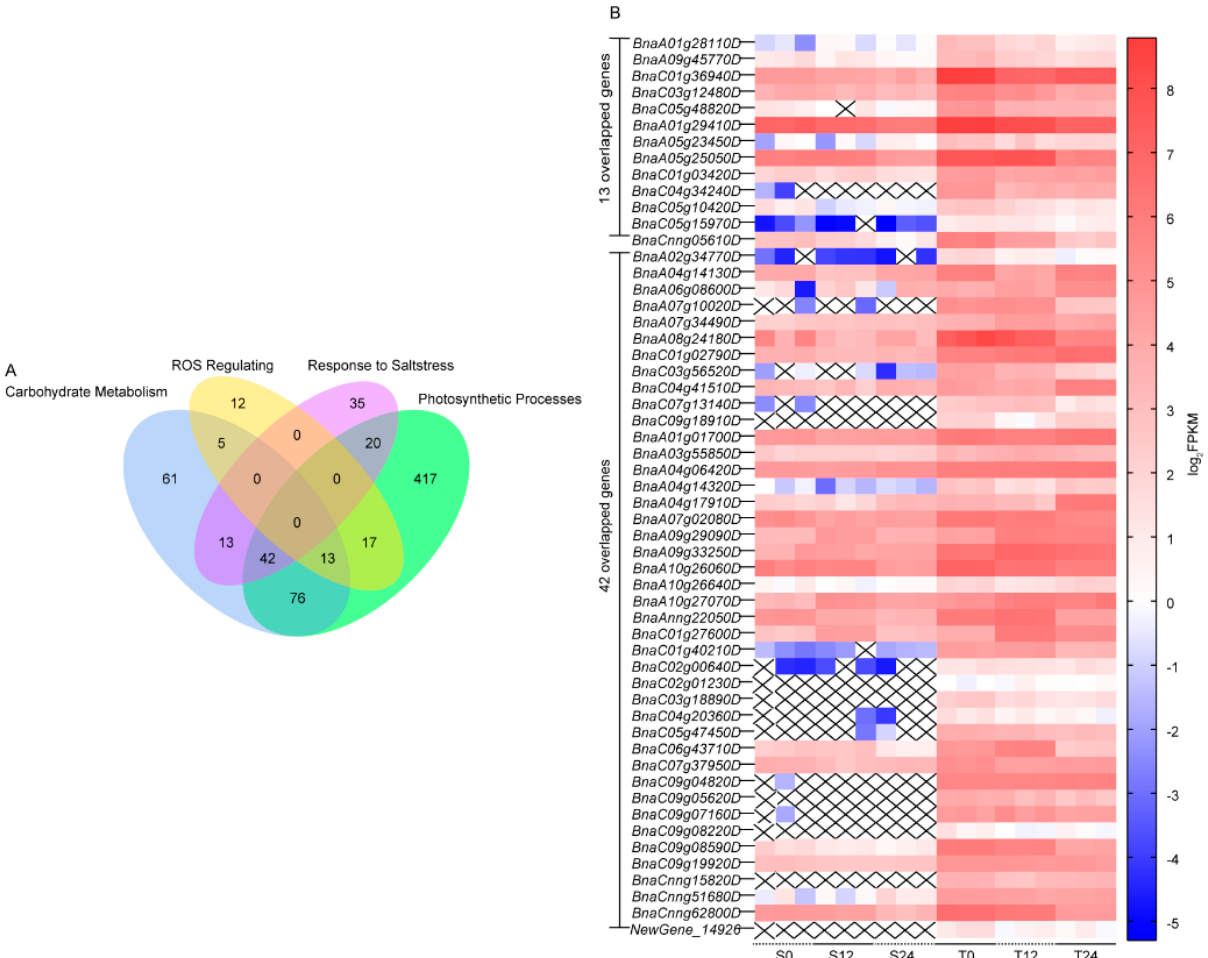
Figure 6. Candidate genes in the target pathways. ( A ) The Venn diagram shows the DEGs in the carbohydrate metabolism, photosynthetic processes, and ROS regulating under salt stress. ( B ) The heatmap displays the Log 2 FPKM of 13 DEGs (overlapped DEGs in photosynthetic processes and ROS regulating) and 42 DEGs (overlapped DEGs in carbohydrate metabolism and photosynthetic processes) for lines 2205 and 1423 under control, 12- and 24-hour stress. The “X” in the figure represents FPKM = 0.